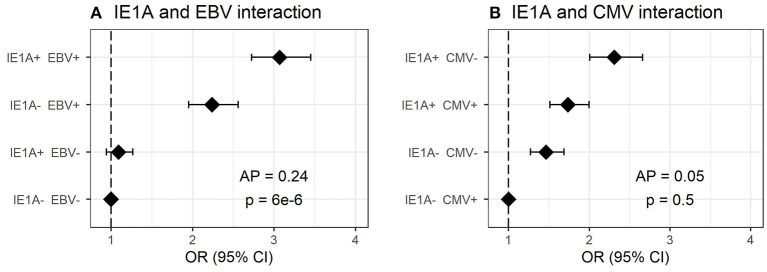
Interaction of antibody response against different herpesviruses in association to MS. Odds ratios (OR) and confidence intervals (CI) for IE1A and EBV (A) and IE1A and CMV (B), were obtained through logistic regression models adjusted for age, sex and cohort type analyzing the Established MS cohort (n = 8,742 persons with MS and n = 7,215 controls). OR were calculated in relation to the group with the lowest MS risk. Plus (+) indicates being a strong responder while minus (–) indicates being a weak responder. Strong IE1A response is defined as having an MFI value being in the upper quartile of measured response, while a low response is having an antibody measurement being in the lower quartile of measured response. Strong EBV/CMV response is defined as having a higher EBV/CMV index than the median among controls, while a weak response is having a lower index compared to the median among controls.